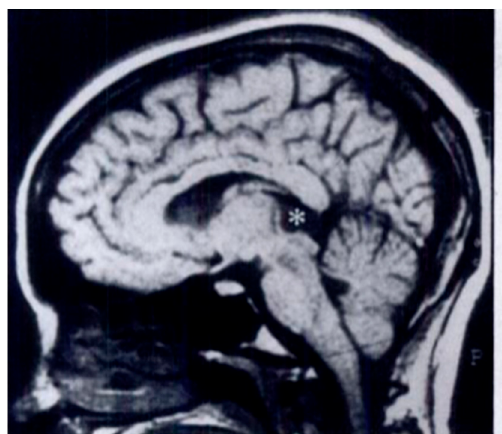
Figure 6. Pineocytoma MRI. The asterisk indicates the homogeneous mass in the pineal gland. Reprinted with permission from Smirniotopoulos et al. (1992) [13]. Radiological Society North America–2021. Small pineocytomas often do not induce symptoms, but if they are of large dimen-